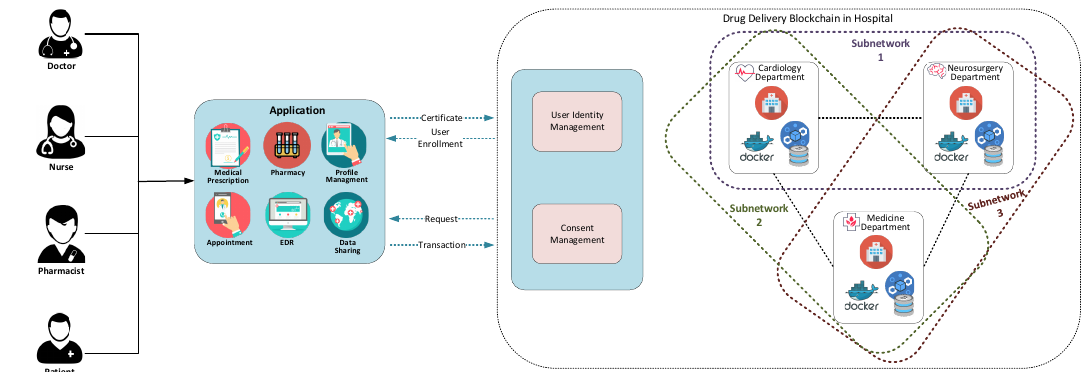
Figure 4. System architecture of the proposed drug supply chain management. The responsibility of a node in a network is to sustain the replica of a blockchain, and it is also responsible for processing the transaction. Figure 5 gives the inside view of a blockchain node. database is used to represent and store the state of the ledger at a given point and time. The sample white box representation of a node indicates the relation between the state database and block.